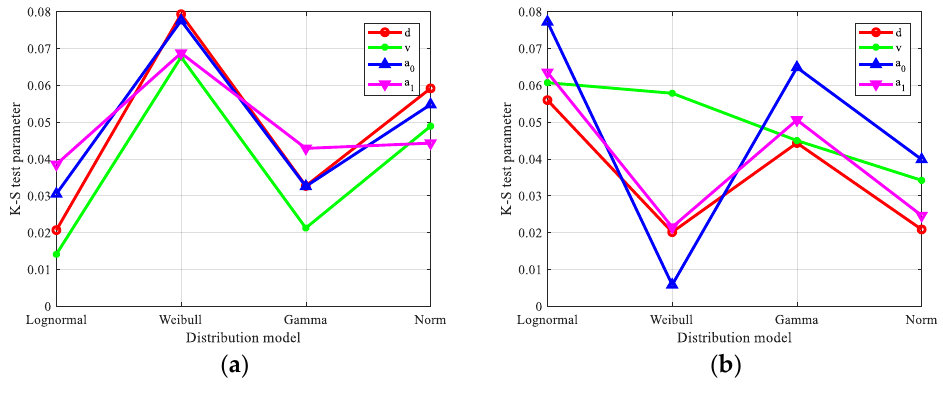
Figure 4. K–S test parameter: ( a ) target, ( b ) clutter. Figure 4. K – S test parameter: ( a ) target, ( b ) clutter. Figure 4. K – S test parameter: ( a ) target, ( b ) clutter. Table 1. The selected statistical model for different feature Table 1. The selected statistical model for different feature parameters Table 1. The selected statistical model for different feature parameters